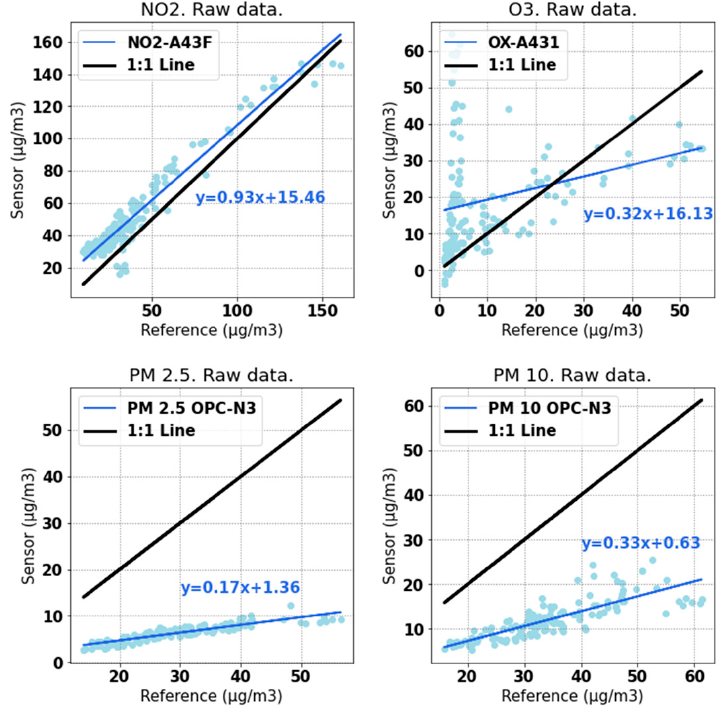
Figure 4. Scatter plots of values ( μ g/m 3 ) from sensors vs. reference.